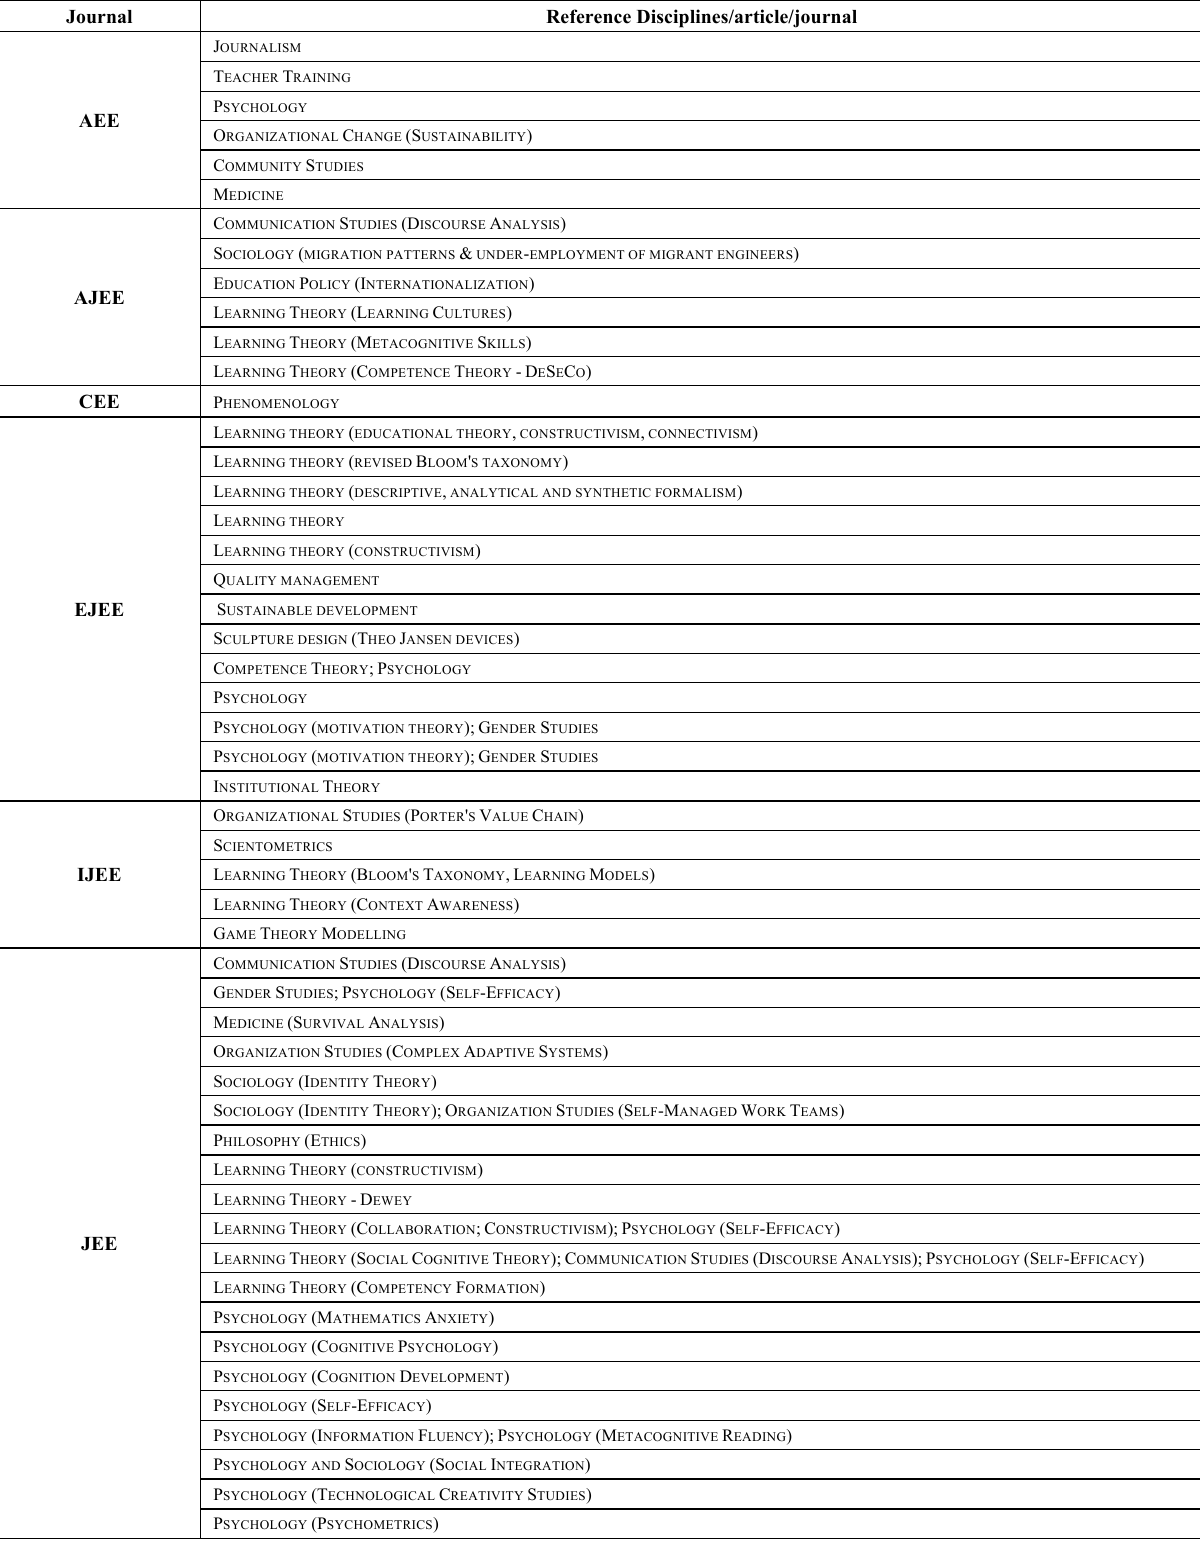
TABLE IV. B REAKDOWN OF R EFERENCE D ISCIPLINES CITED IN THE JOURNAL